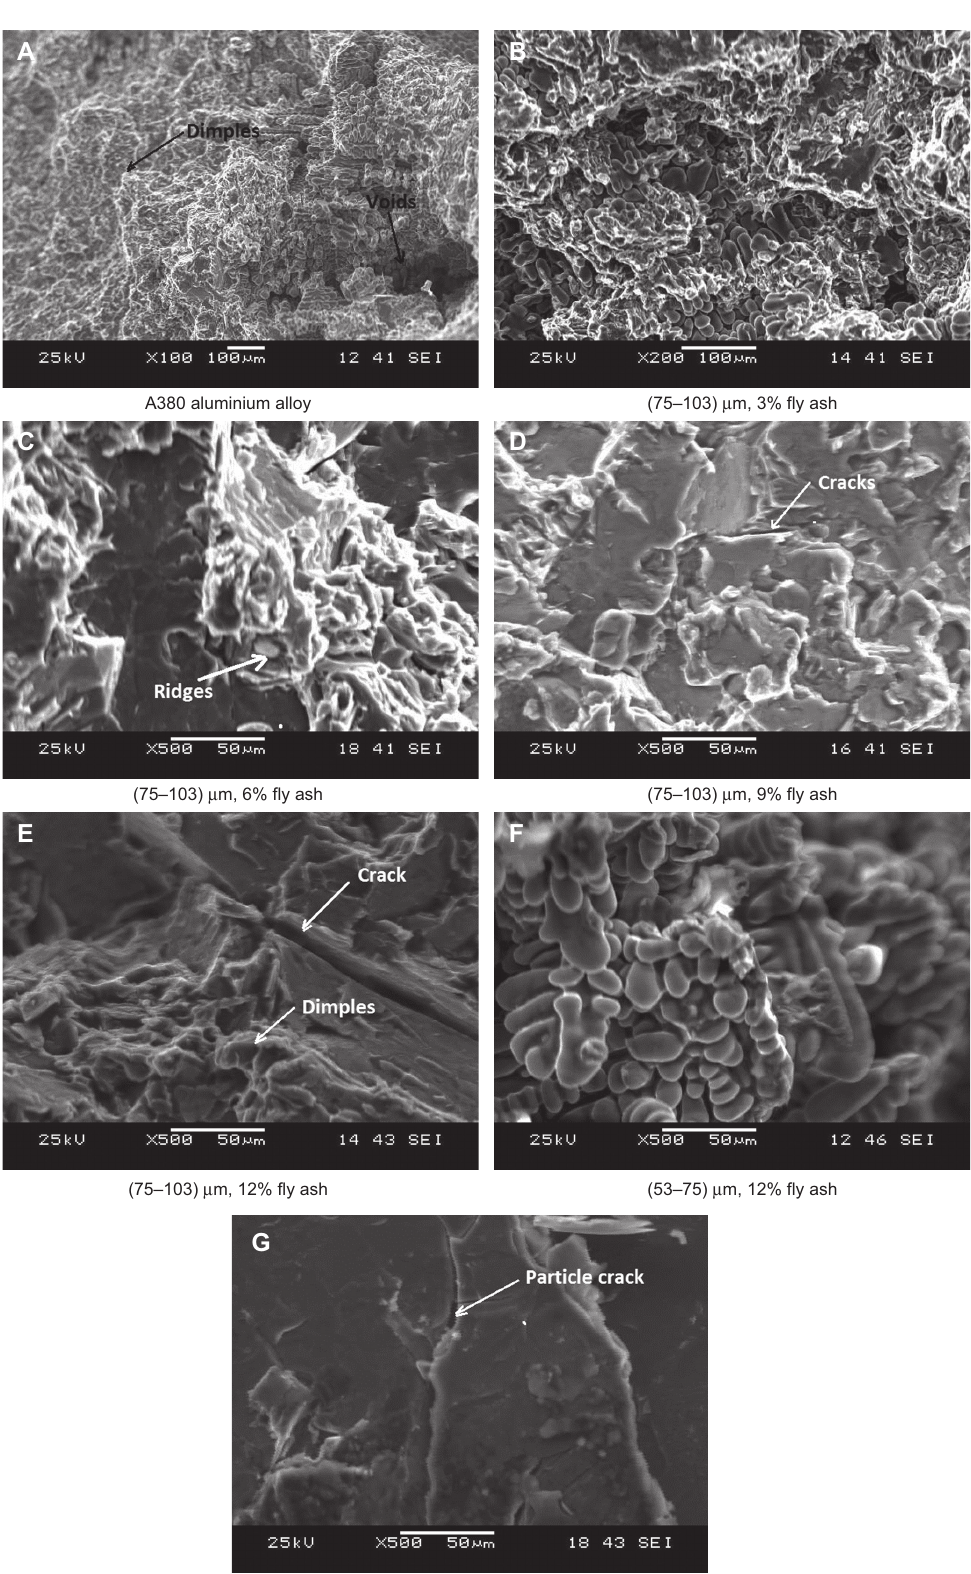
Figure 4 Fracture surfaces of the tensile test